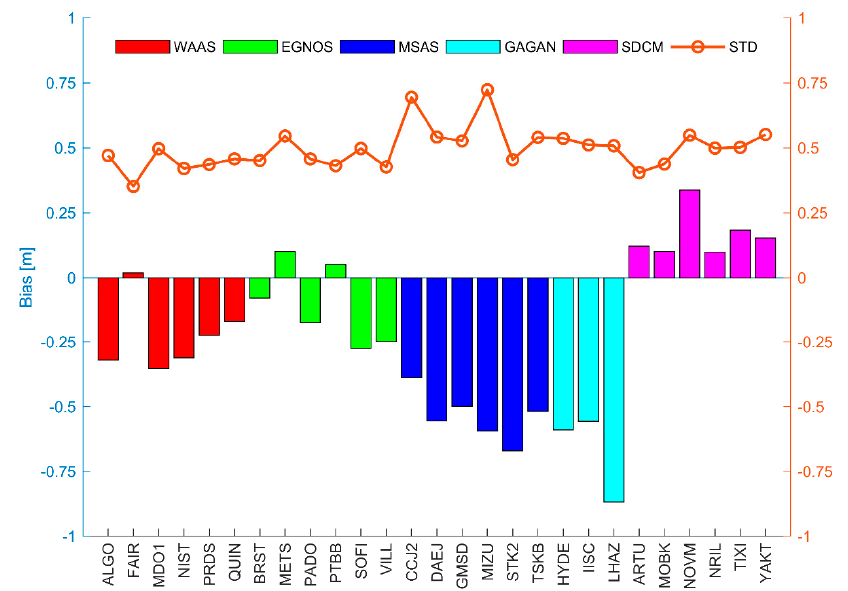
Figure 15. The bias and standard deviation (STD) values of SBAS ionospheric correction errors for each selected IGS station.